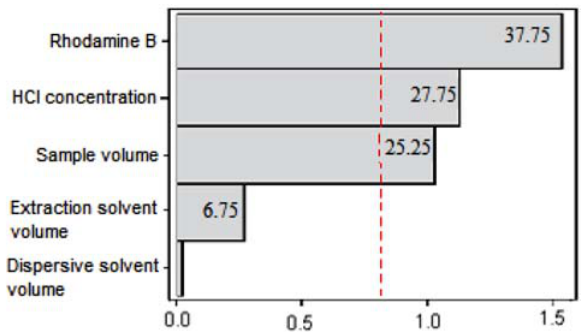
Figure 2. Pareto charts of the main effects obtained from the Plac- kett Burman design